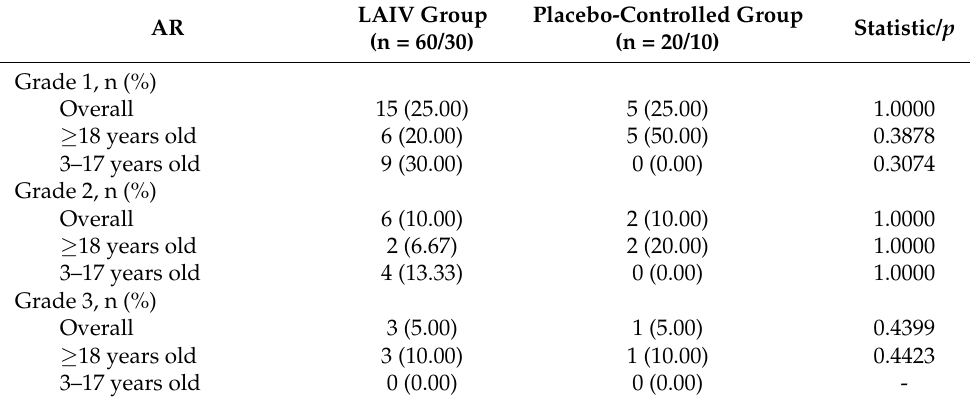
Table 3. Grading of adverse reactions (SS).